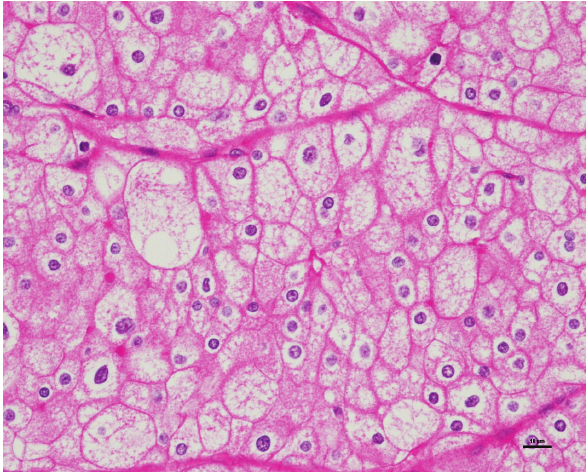
Figure 1: Classical chromophobe renal cell carcinoma pattern with wide constitutive nuclear range, without nuclear crowding